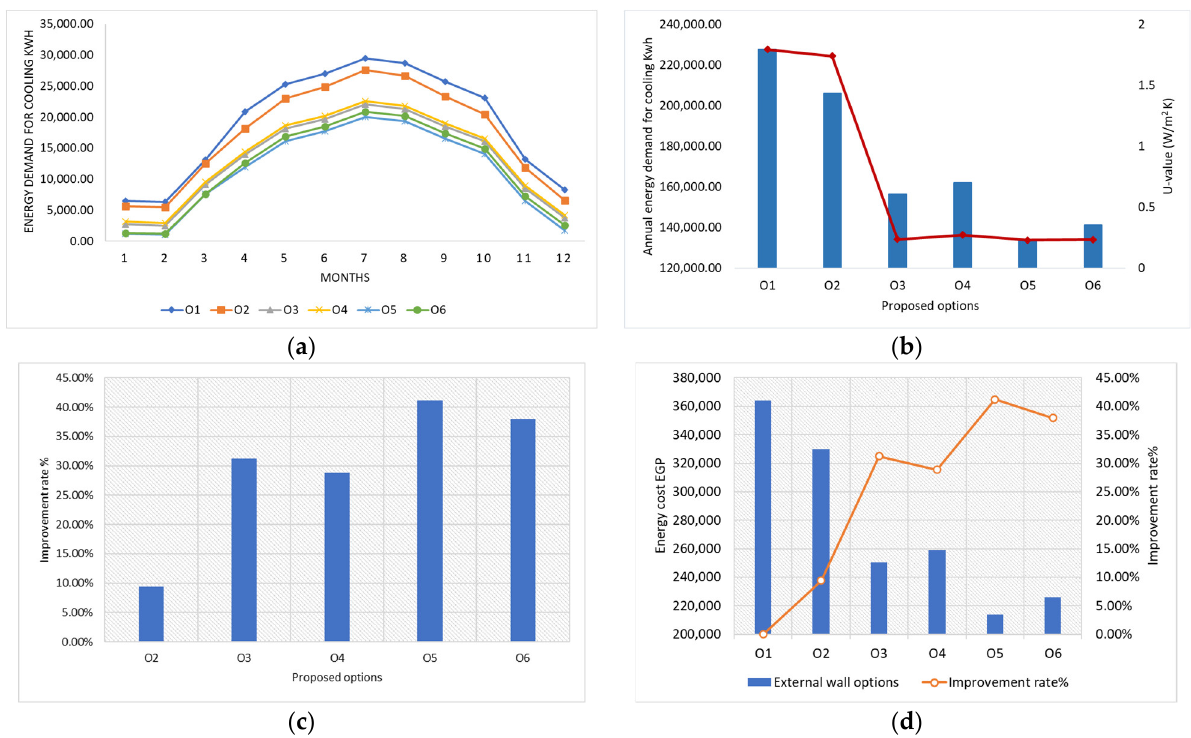
Figure 8. Simulation results in terms of energy required for cooling: ( a ) the monthly energy needed for cooling; ( b ) the annual energy demand for each option; ( c ) the improvement rate for the studied options; ( d ) the annual energy cost per (EGP).